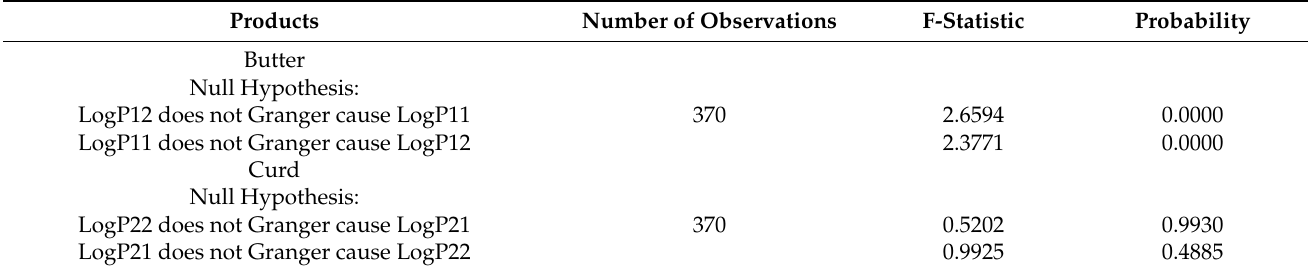
Table 2. Pairwise Granger causality test results for 40 lags of daily butter and curd prices in Poland. Products